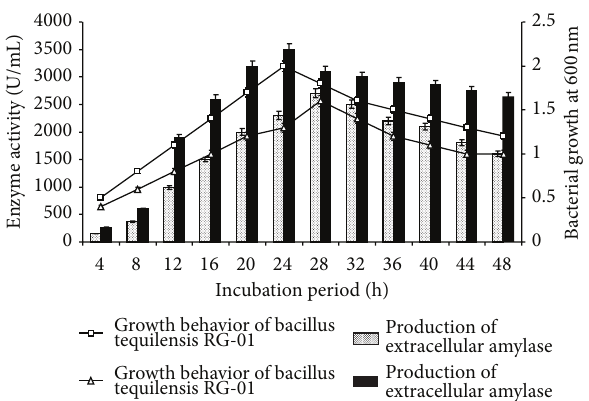
Figure 2: Growth behavior of Bacillus tequilensis RG-01 and pro- duction of extracellular amylase, respectively, in starch nutrient media and modified starch nutrient media at initial pH 7.0 and 55 ∘ C and 120rpm during 48 h growth.